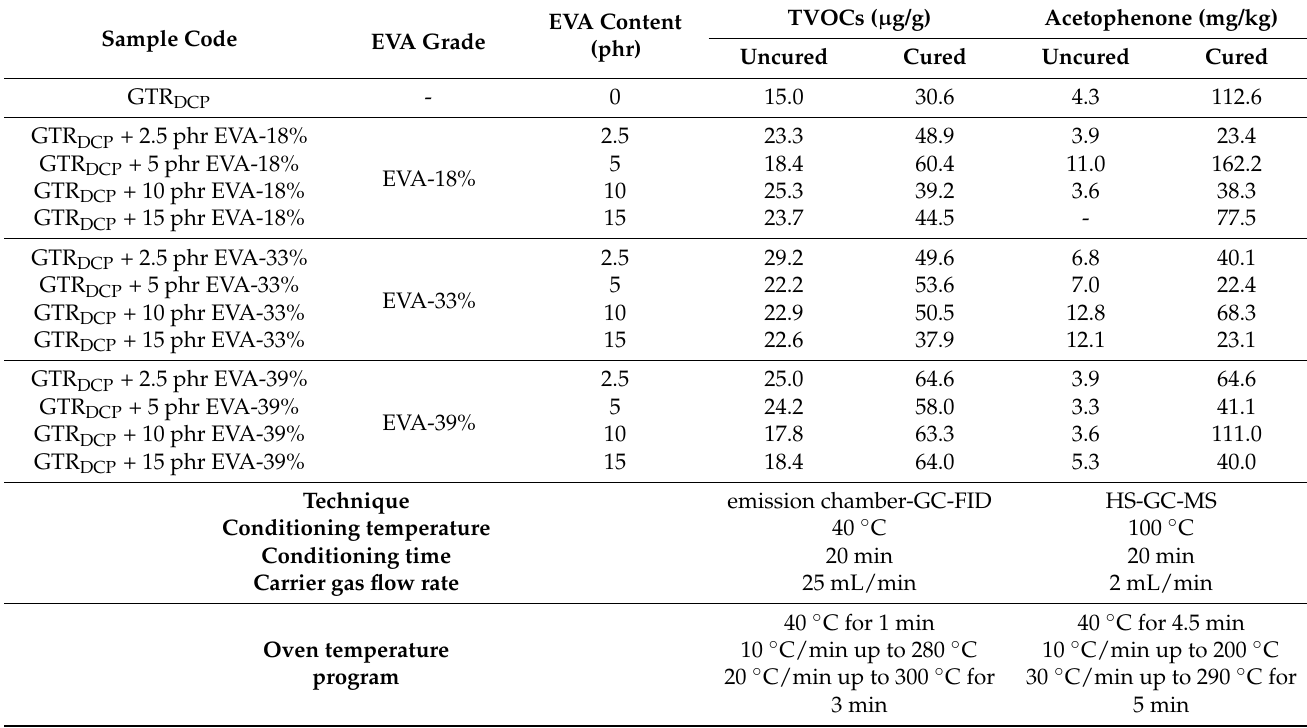
Table 5. TVOCs and acetophenone level determined for uncured and cured modified GTR.